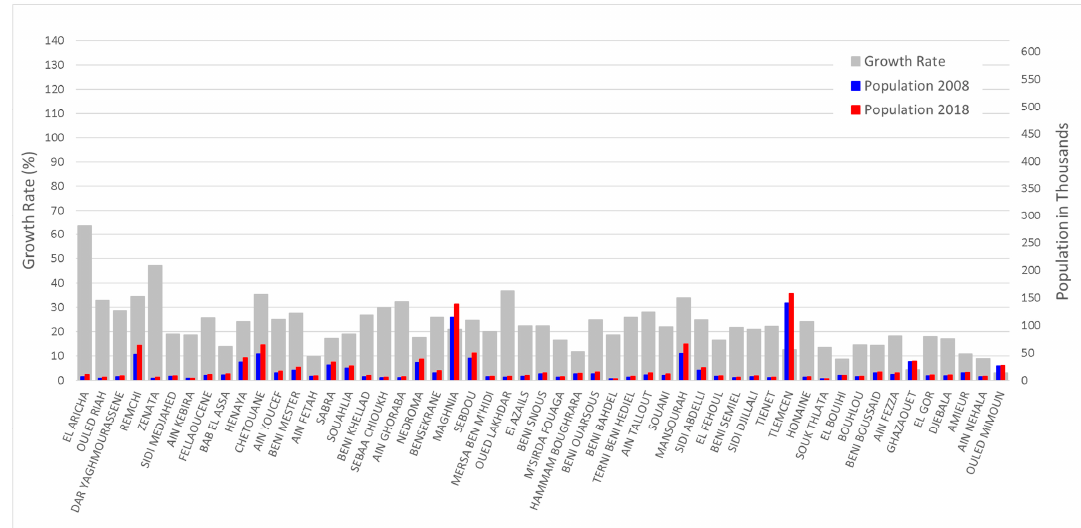
Figure 3. Population (thousands of persons) and growth rate (%) for the communes in the Tlemcen wilaya between 2008 and 2018.